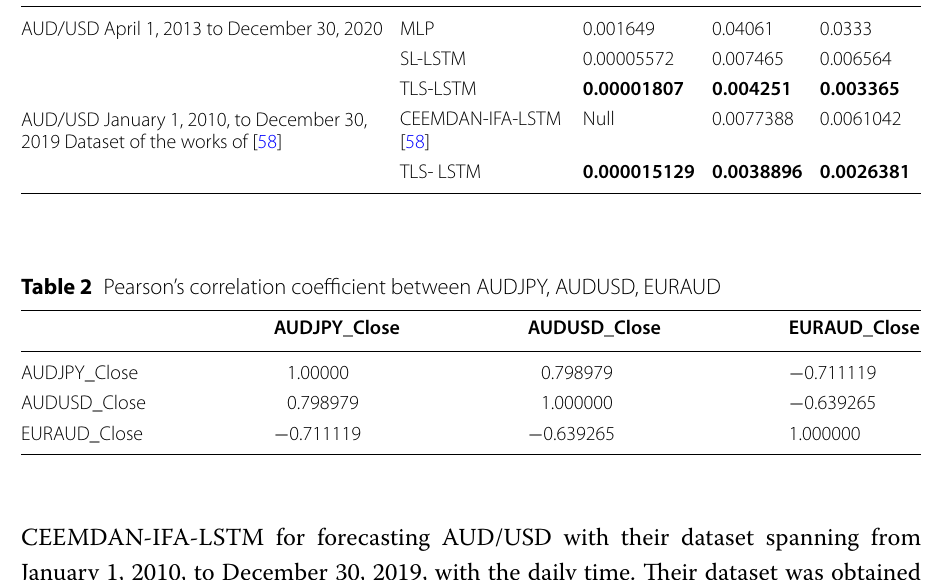
CEEMDAN-IFA-LSTM for forecasting AUD/USD with their dataset spanning from